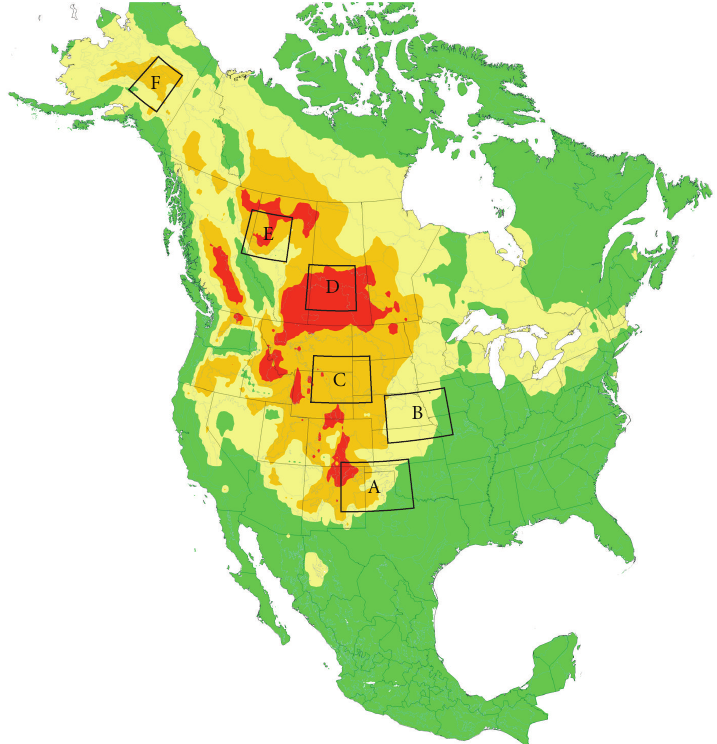
Figure 4: Predicted distribution and abundance (EI) of Melanoplus sanguinipes for 2080 (NCAR273 CCSM) at six regions: (A) Lubbock, TX; (B) Lincoln, NE; (C) Gillette, WY; (D) Saskatoon, SK; (E) Peace River, AB; (F) Fairbanks, AK. Green = “Unfavourable” (EI = 0 − 5); Tan = “Suitable” (EI = 5 − 20); Orange = “Favourable” (EI = 20 − 30); Red = “Very Favourable” (EI ≥